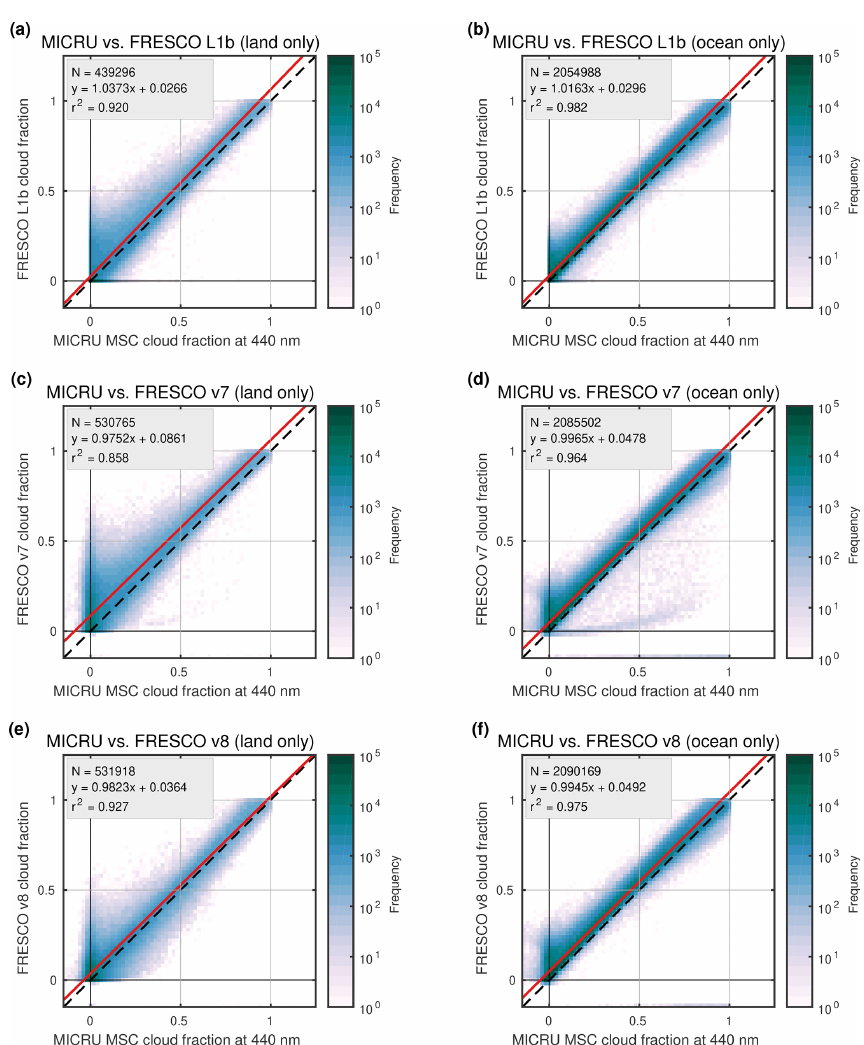
Figure 21. Comparison between MICRU MSC at 440nm and three different FRESCO versions based on CF data from April 2010: measure- ments over land (a, c, e) and ocean (b, d, f) ; FRESCO L1b (a, b) , FRESCO v7 (c, d) , and FRESCO v8 (e, f) . The comparison to FRESCO L1b applies cropped data. The comparisons in panels (c) – (f) only exclude CF >